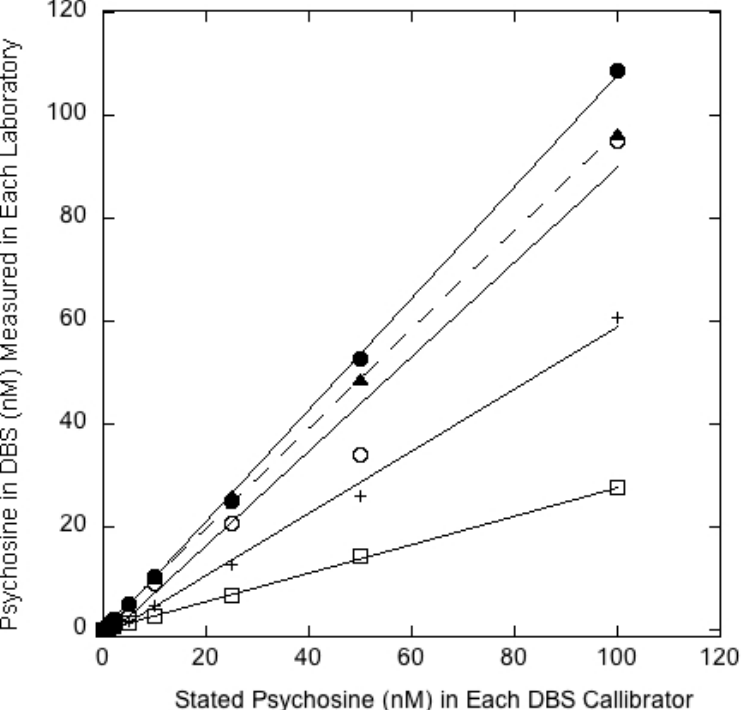
Figure 2. The y -axis gives the psychosine value (nM) measured in each laboratory by their LC-MS/MS method. The x -axis gives the vendor stated psychosine values (nM) for each dried blood spot (DBS) calibrator: Filled circles/solid line (Nationwide), open circles/solid line (Mayo), filled triangles/dotted line (PerkinElmer), open squares/solid line (NY Wadsworth Center), plus signs/solid line (GelbChem LLC).